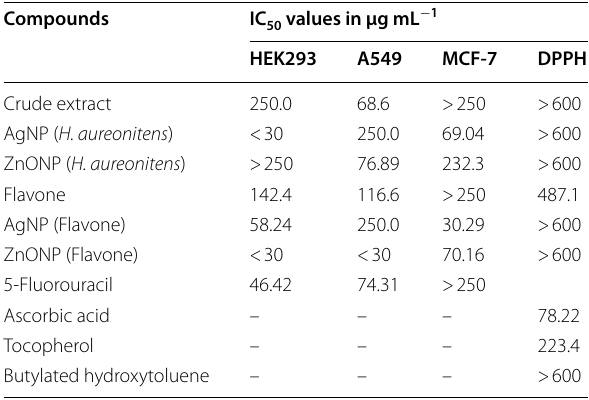
Table 1 IC values of the crude extract, flavone and 50 nanoparticles synthesized from H. aureonitens on HEK293, A549, and MCF-7 cell lines and